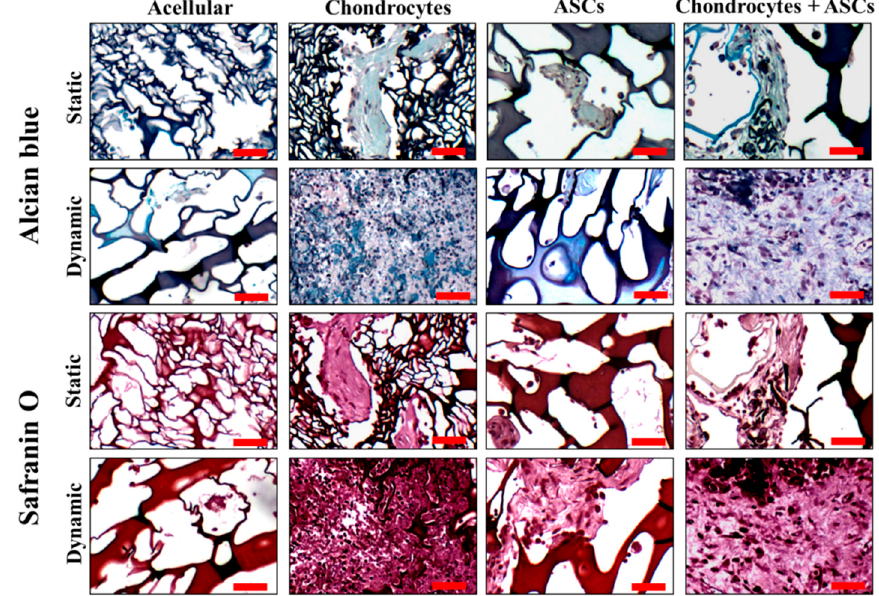
Figure 7. Alcian blue and Safranin O staining of implants eight weeks after subcutaneous implantation in nude mice. The cells/scaffold constructs were cultured in cryogel scaffolds for 14 days under static or cyclic compressive loading (frequency = 1 Hz, strain = 20% and duration = 3 h/day) conditions before implantation. Scale bar = 50 µm.